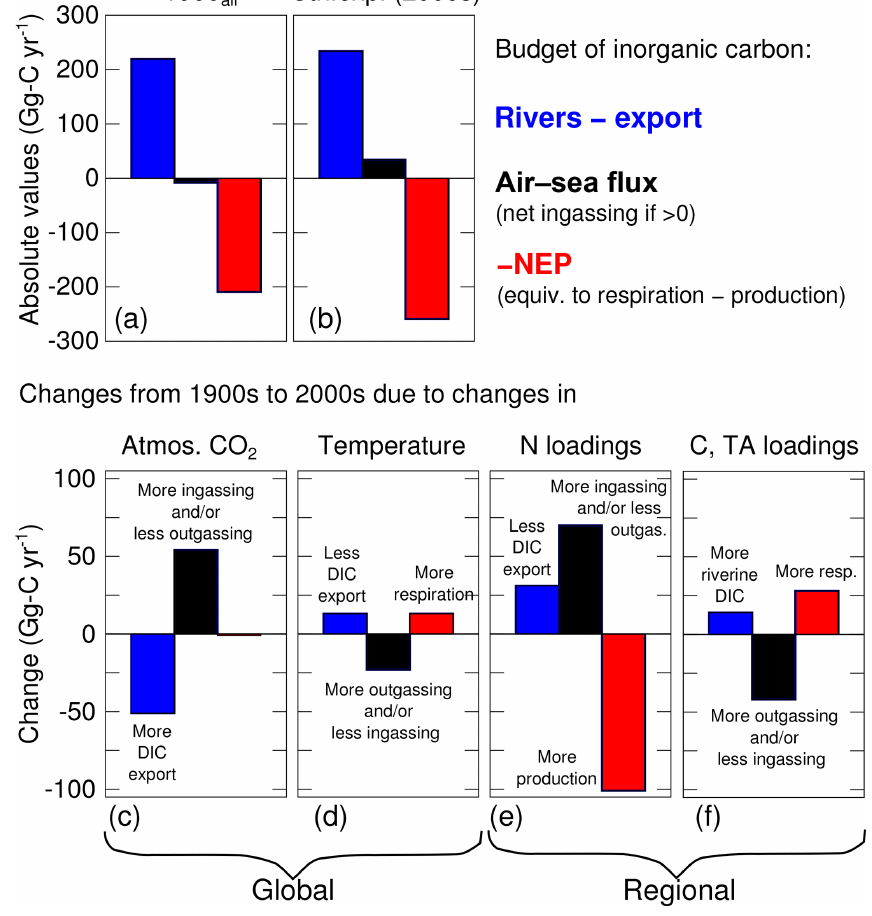
Figure 7. Summary of the changes in the inorganic carbon system for the six model experiments (Table 1). “Rivers minus export” combines the riverine DIC input and the export of DIC at the bay’s mouth (Table 4). NEP is net ecological production (see Methods